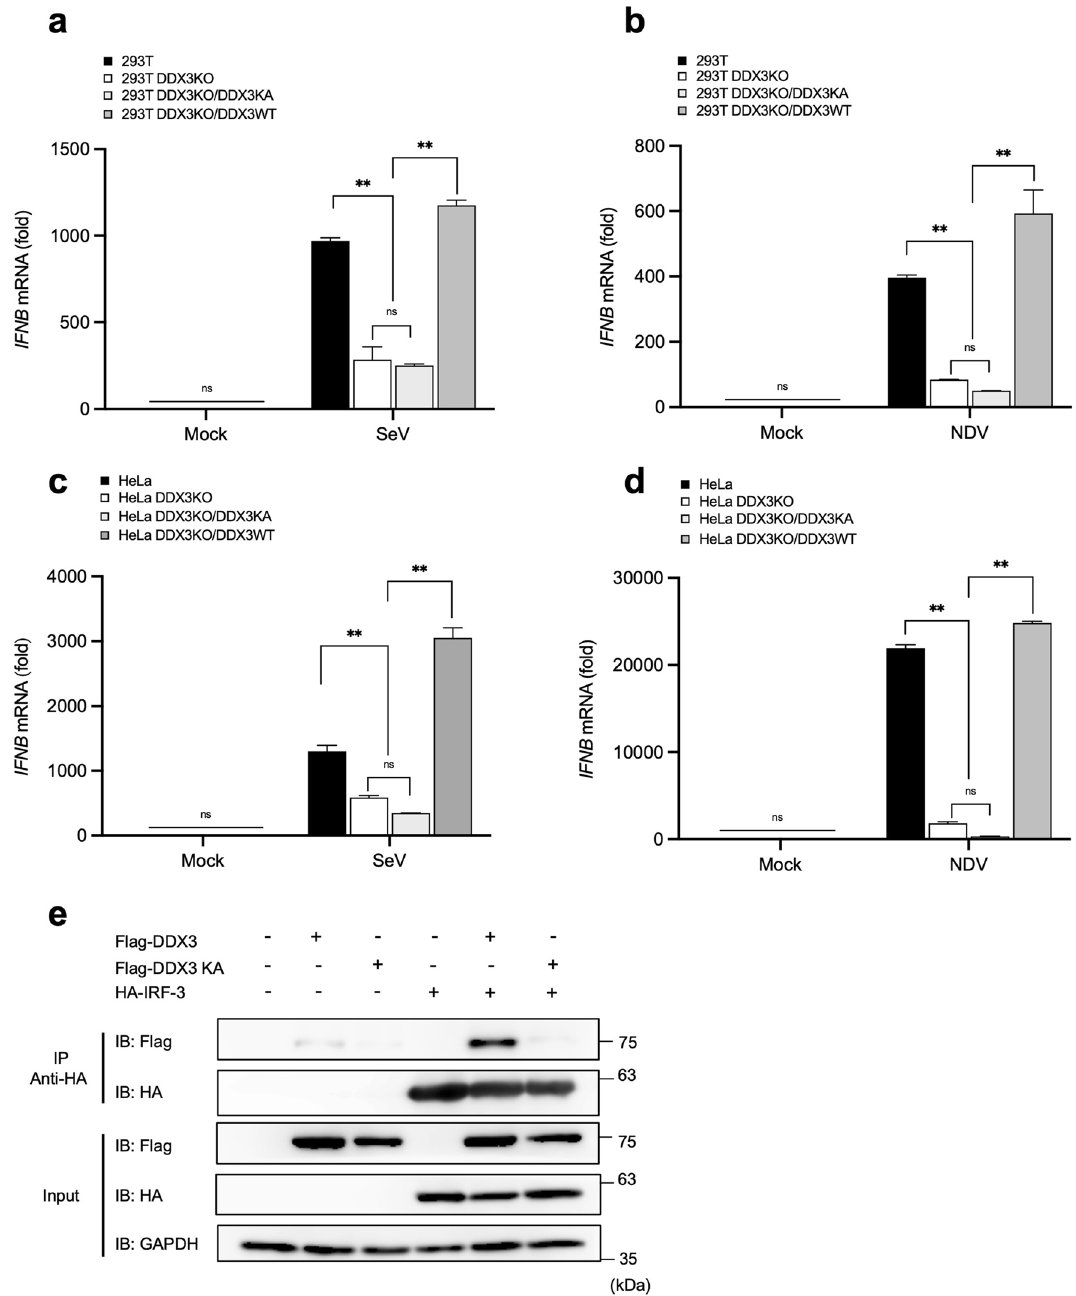
Figure 6. Failure of DDX3KA to complement DDX3 function to support IFNB gene expression and to interact with IRF-3 q-PCR analysis of IFNB mRNA in 293T, 293T DDX3KO, 293T DDX3KO/DDX3KA, and 293T DDX3KO/DDX3WT cells infected with SeV ( a ) and NDV ( b ) for 12 h. q-PCR analysis of IFNB mRNA in HeLa, HeLa DDX3KO, HeLa DDX3KO/DDX3KA, and HeLa DDX3KO/DDX3WT cells infected with SeV ( c ) and NDV ( d ) for 12 h. The results are presented as fold expression of IFNB mRNA to that of GAPDH . Data are presented as the mean ± SEM and are one representative of two independent experiments. Data were analyzed using two-way ANOVA with Tukey’s post-test ( a – d ). ** p < 0.001. ns, not significant. ( e ) 293T cells were transiently transfected with the expression vector for Flag-DDX3, Flag-DDX3KA, or HA-IRF-3 as indicated. Whole cell lysates were subjected to immunoblotting for Flag, HA, and GAPDH (input). Whole cell lysates were immunoprecipitated by anti HA and the precipitates were analyzed by immunoblotting for HA or Flag. Full- length gels in Supplementary